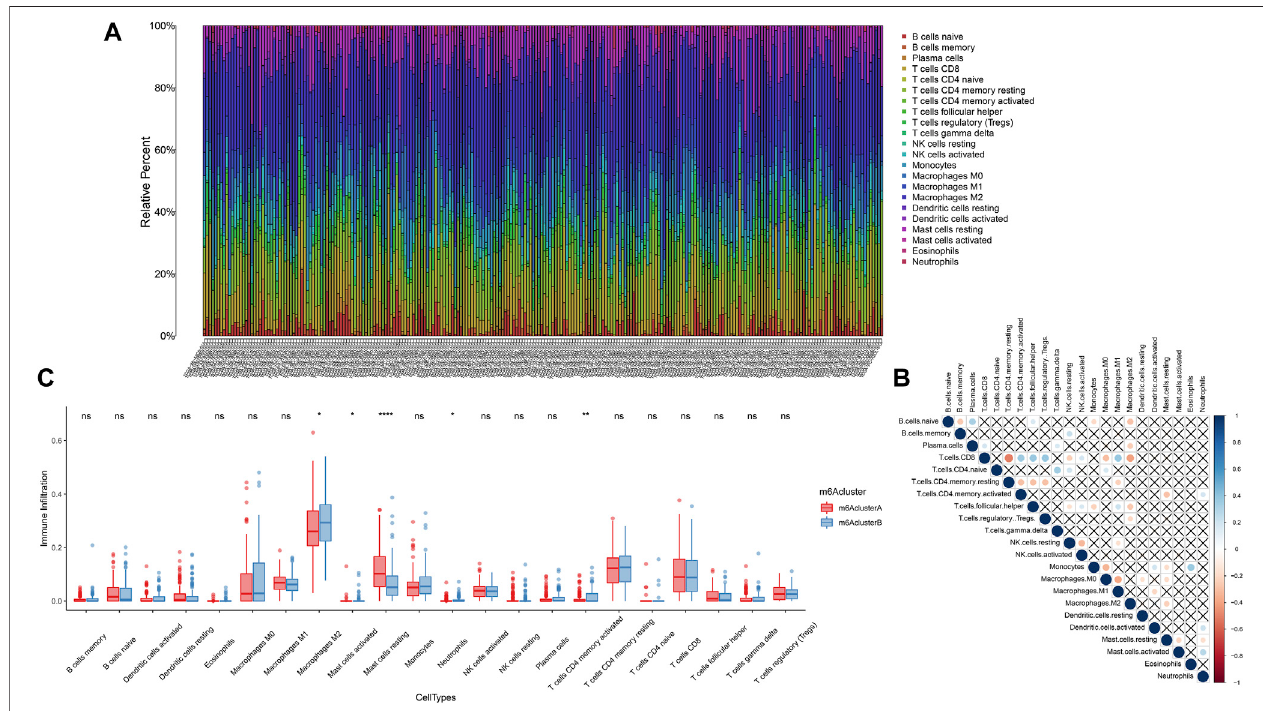
FIGURE 5 | Effects of different m6A modi fi cation patterns on the immune in fi ltration of STS. (A) Immune in fi ltration of each sample in TCGA-SARC. (B) Correlation plot of each immune cell in TCGA-SARC. (C) Comparison of immune cell in fi ltration among m6A clusters A and B.